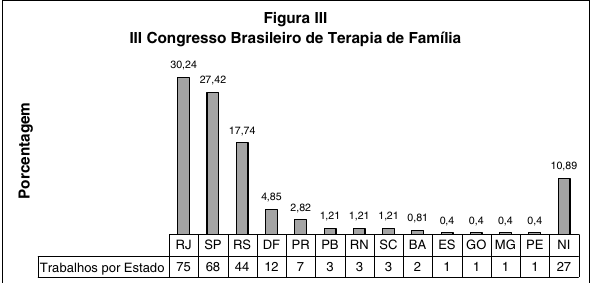
Figura 3. III Congresso Brasileiro de Terapia de Família.